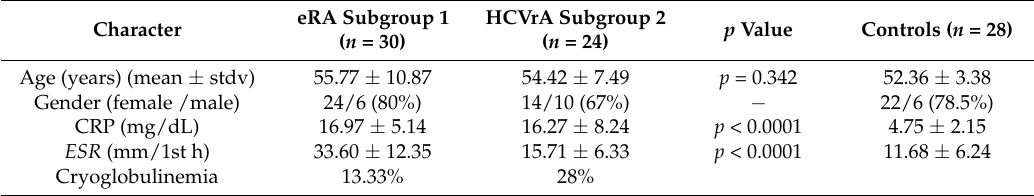
Table 1. Clinical characteristics of the study